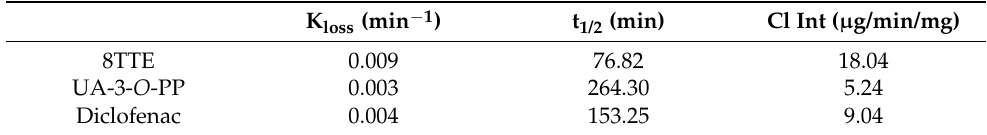
Table 4. Elimination rate constant, half-life (min), in vitro intrinsic clearance ( µ L min − 1 mg − 1 protein) calculated for tested triterpenic esters and